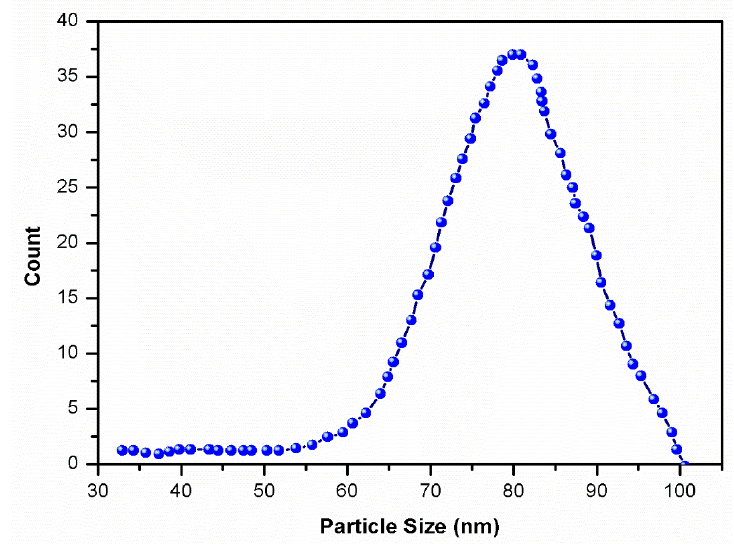
Figure 3. Histogram of ZnO particle size distribution.